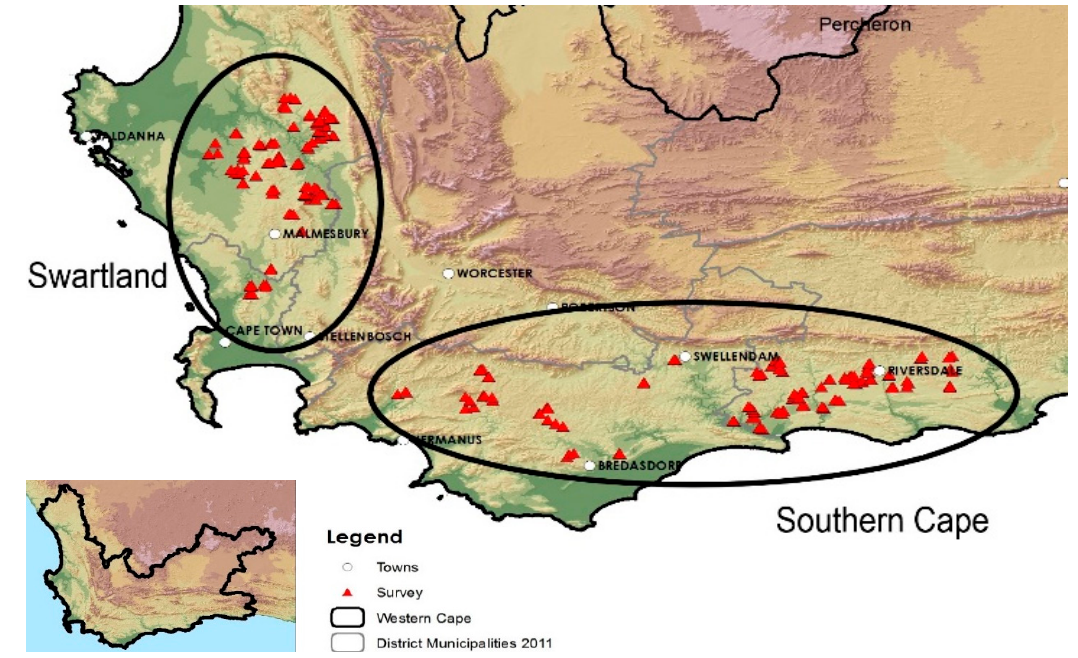
Figure 5. A map indicating the surveyed area, which included the southern Cape and Swartland regions of the Western Cape Province of South Africa.